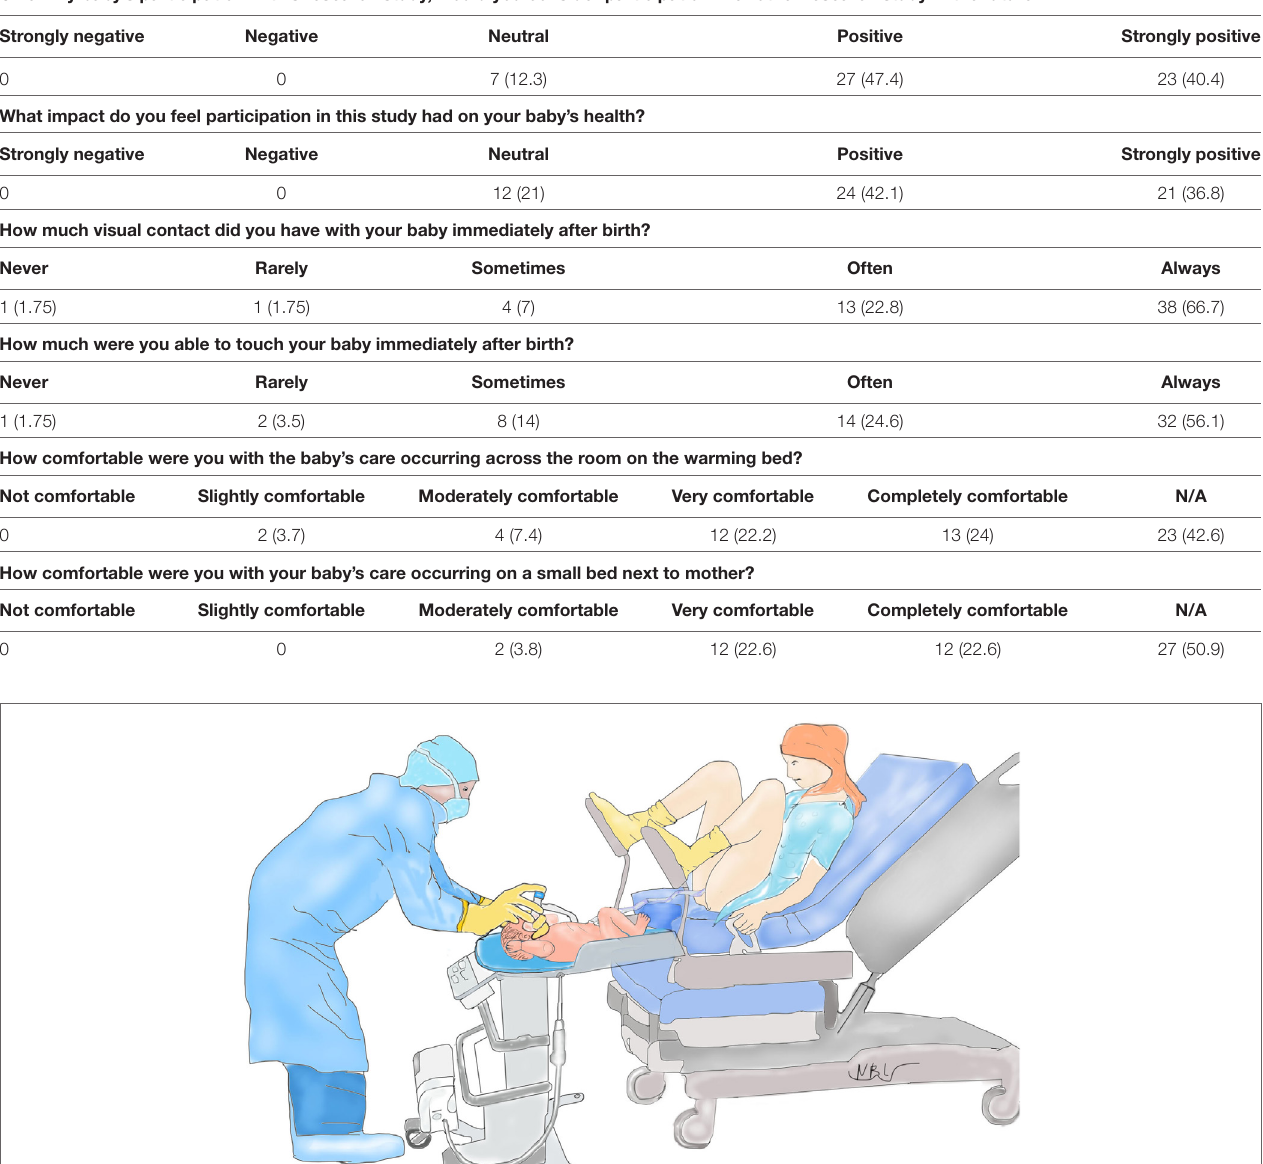
TaBle 5 | Responses to the parent questionnaire.